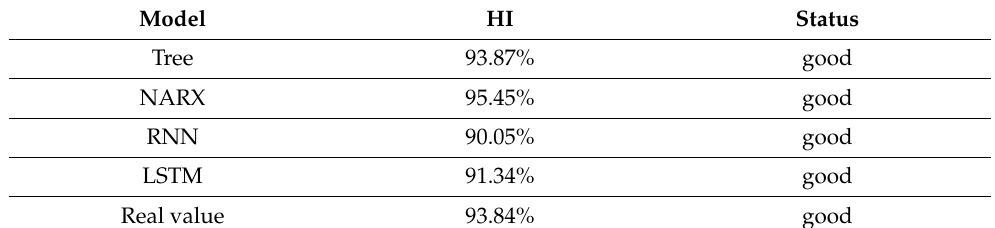
Table 7. Health indicators of different models (50 cycles).